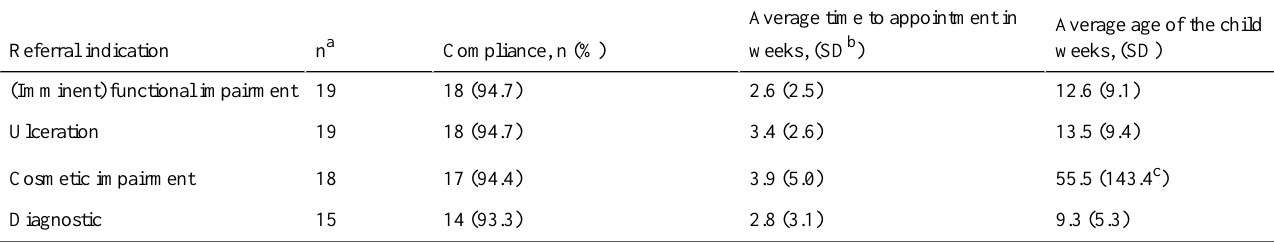
Average age of the